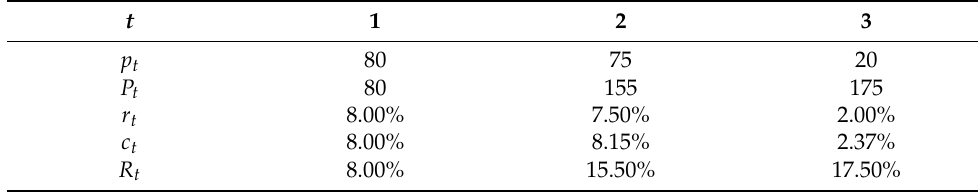
Table 3. Portfolio ( EAD = 1000 ) performance in 3 years ( T = 3